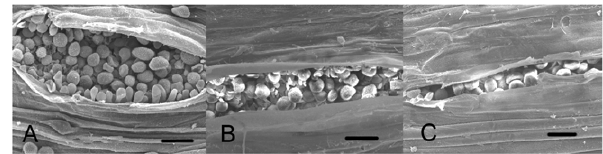
Figure 7. SEM photograph of uredia after HIGS at 16 dpi. Sorus of silenced PsCNA1/PsCNB1 of Pst infected leaves inoculated with CYR31. Scanning electron micrographs by 600 6 , scale bar: 20 m m. A: BSMV: c :0-as (empty viral vector control); B: BSMV: c : PsCNA1 -as (silencing PsCNA1 ); C: BSMV: c : PsCNB1 -as (silencing PsCNB1 ).